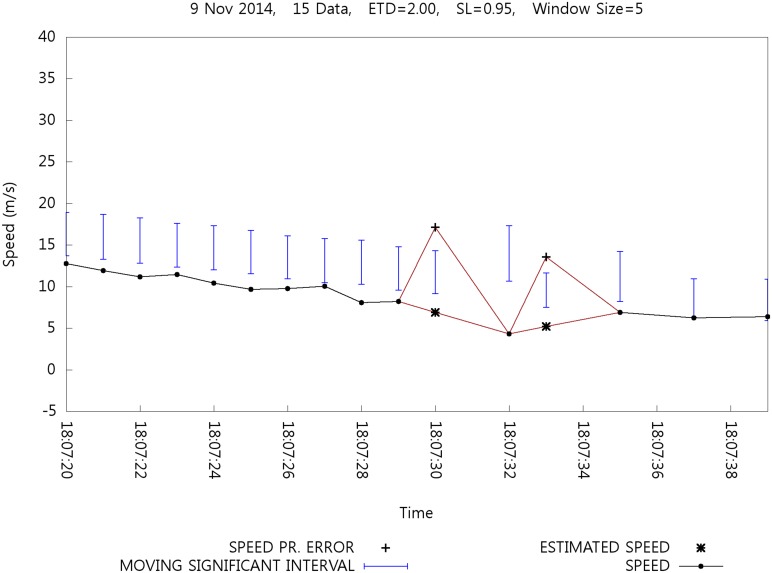
Effect of Speed Estimation.